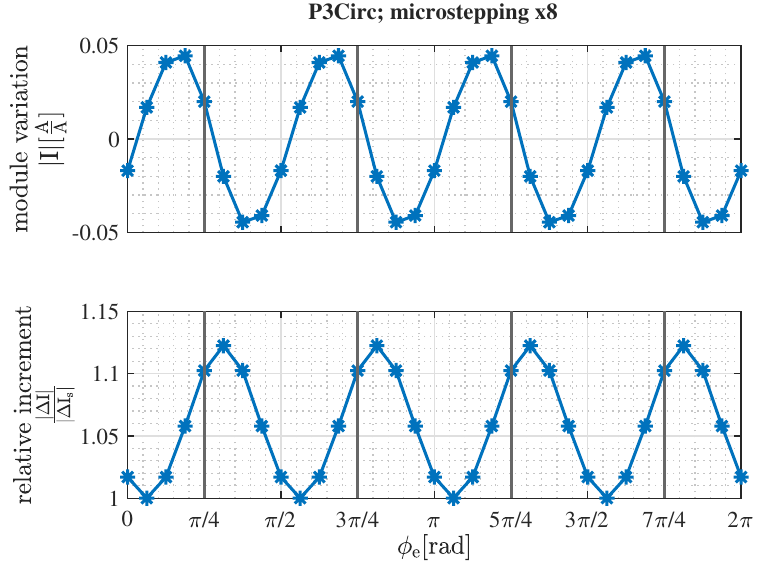
Figure 6. Torque variation and increment relative to a sine-cosine microstepping of equal resolution; p = 3, microstepping resolution